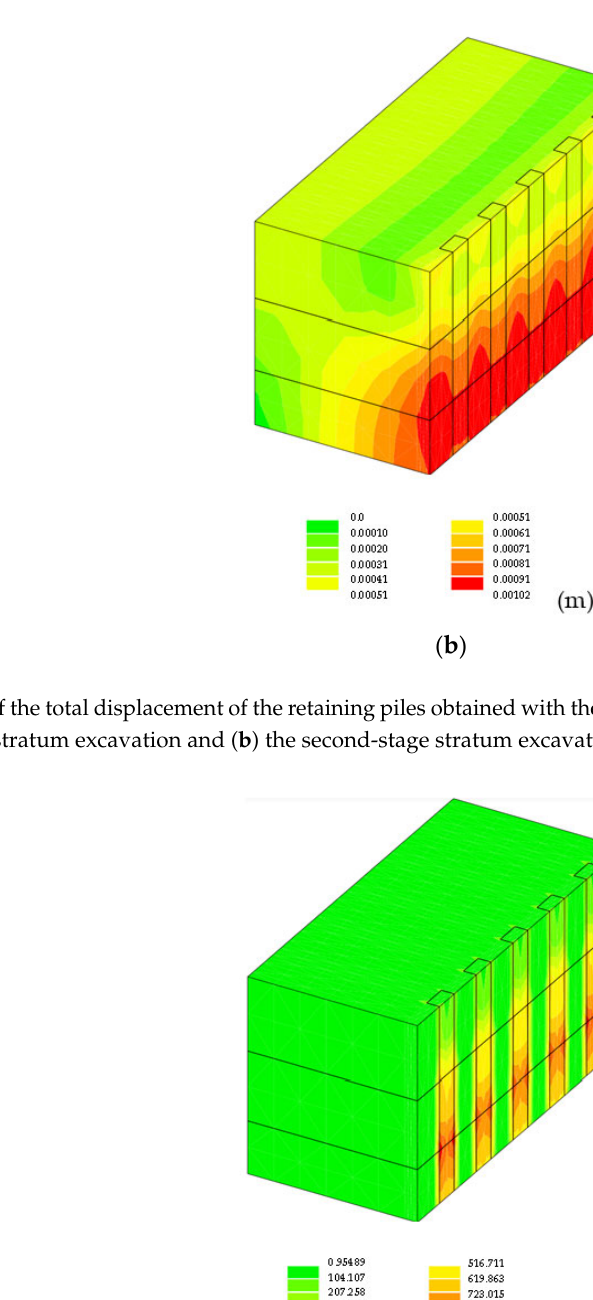
Figure 11. Iso ‐ value of the total displacement obtained with the 3D FEM analysis for ( a ) the first ‐ stage stratum excavation and ( b ) the second ‐ stage stratum excavation.